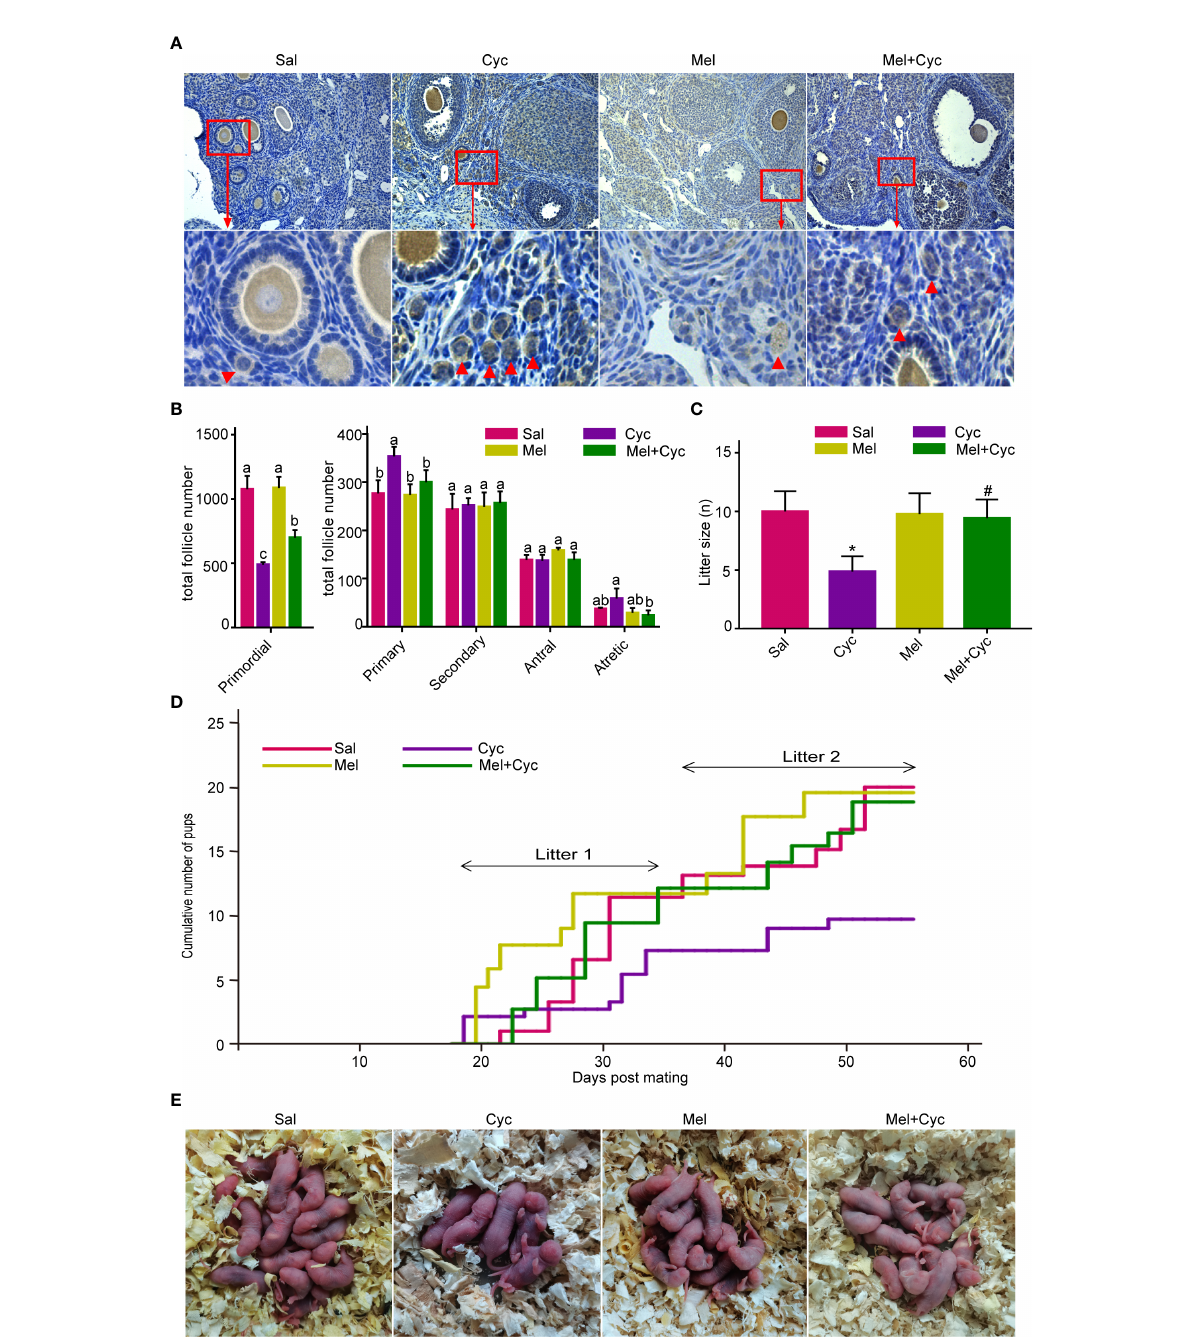
FIGURE 2 Mel prevents Cyc-induced primordial follicle loss. There were 25 six-week-old female mice in each group, of which 18 were sacri fi ced to obtain the ovary and blood samples, and seven mice were used for the mating experiment. (A) Oocytes in mouse ovaries were detected using an Nobox antibody (n = 6). Red arrow indicates primordial follicles. Bar = 200 m m. (B) Follicle count of whole ovarian tissue in control and treatment group mice 14 days after Cyc chemotherapy (n = 6). Mel prevented Cyc-induced dormant primordial follicle loss and suppressed the activation of primordial follicles into primary follicles. a,b,c,d Values with different letters in the same type of follicles were signi fi cantly different from each other. (C) Cyc treatment reduced the mean litter size in mice and Mel reversed this effect (n = 7). * P < 0.05 compared with Sal group. # P < 0.05 compared with Cyc group. (D) Cumulative pup number of each mouse in control and treatment groups at Day 55 of mating (n = 7). (E) Representative litters from control and treatment